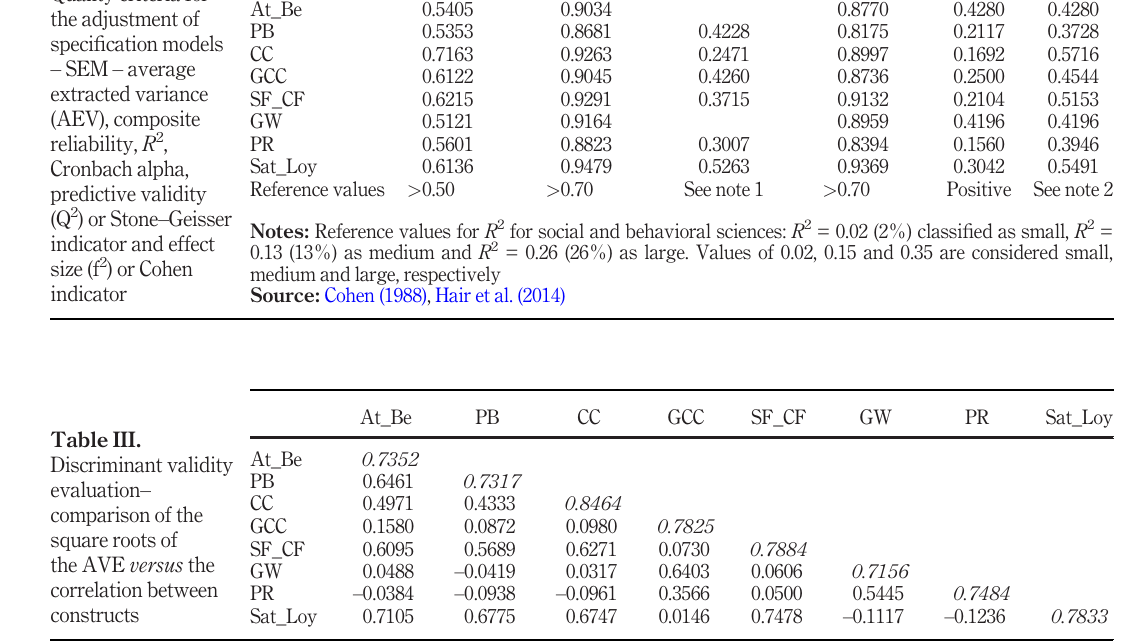
Table II. Quality criteria for the adjustment of